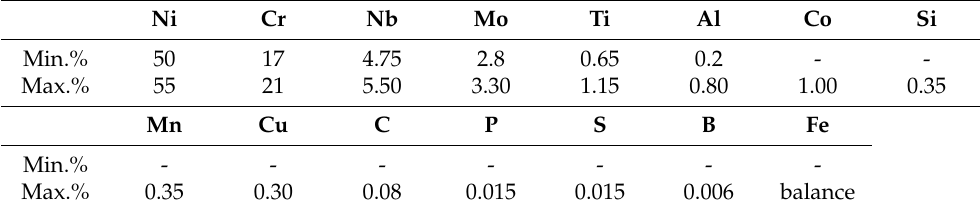
Table 1. Mass fractions of elements in Inconel 718 alloy.